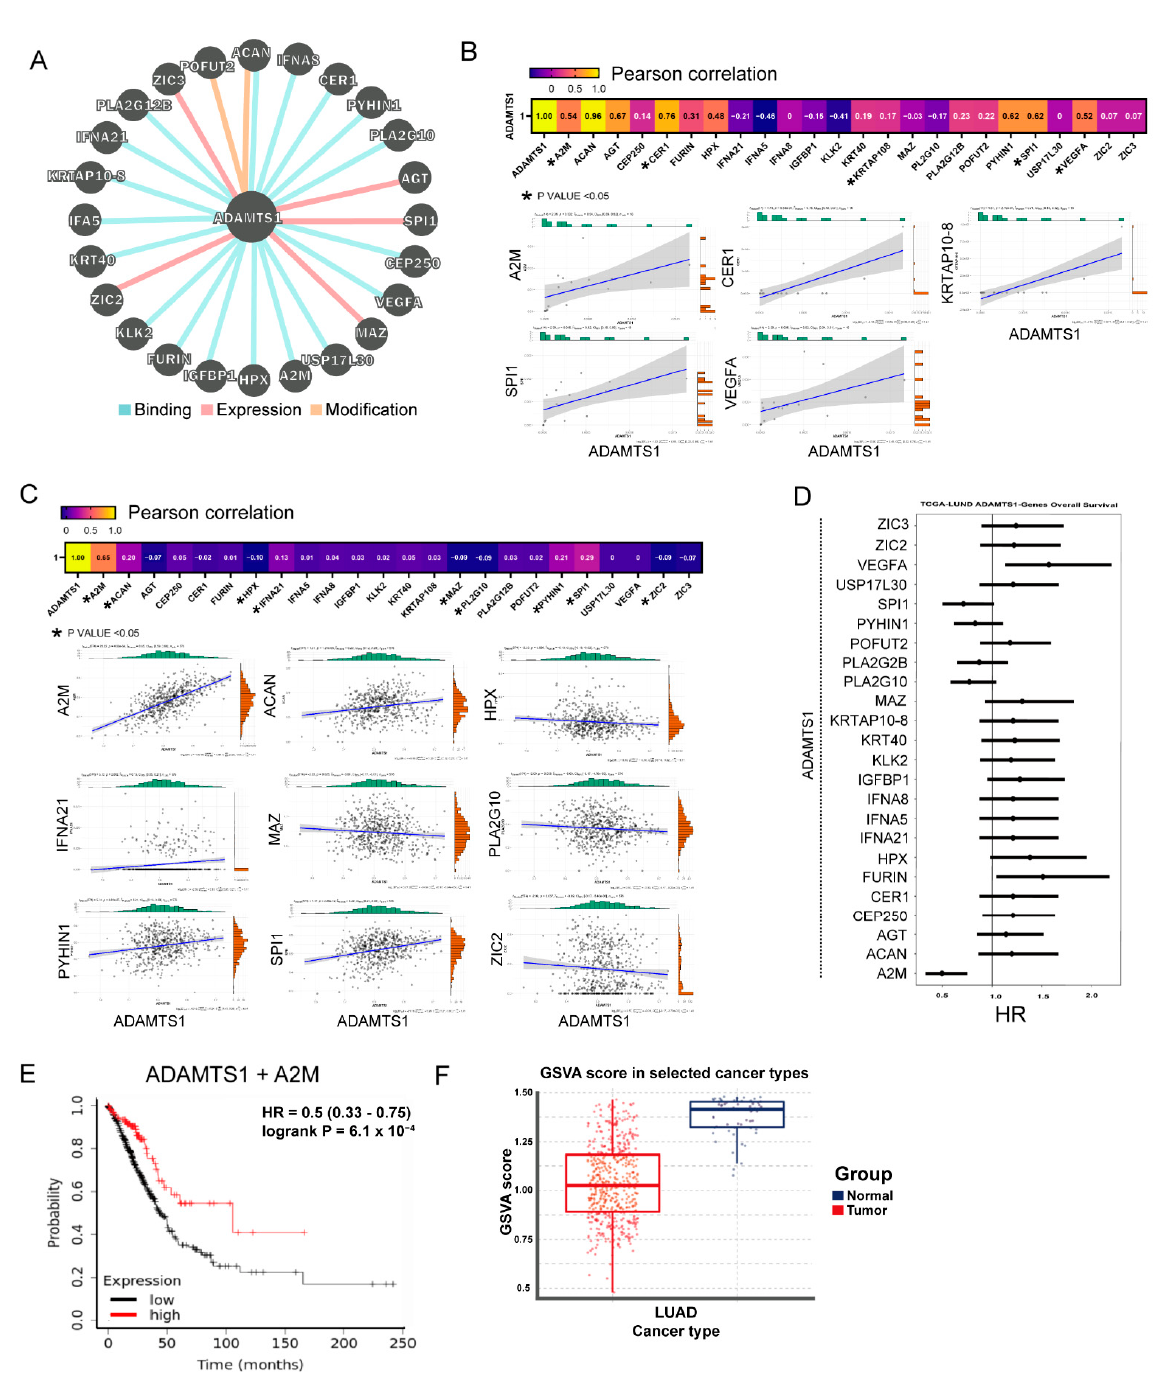
Figure 3. Interaction network of ADAMTS1 in LUAD. ( A ) Interaction network of ADAMTS1 with 25 other genes analyzed by Pathway Commons. ( B ) Correlation between ADAMTS1 and these genes in the in-house LUAD patients ( C ) and in the TCGA cohort ( D ). ( E ) Weight analysis of ADAMTS1 and A2M on overall survival (OS) of patients with LUAD. ( F ) The gene set variation analysis ( GSVA ) analysis of ADAMTS1 and A2M in TCGA datasets.